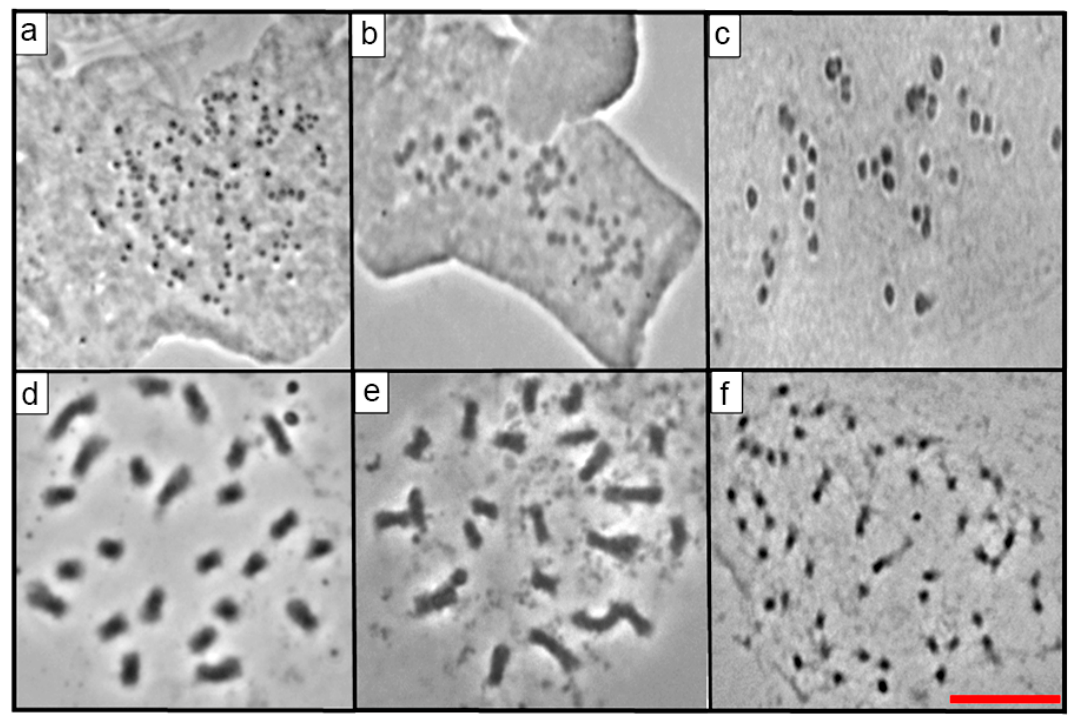
Figure 1. ( a ) Echeveria altamirae 2 n = 108, ( b ) E. caamanoi 2 n = 60, ( c ) E. carnicolor 2 n = 36, ( d ) E. catorce 2 n = 24 (Accession number JE-5469), ( e ) E. catorce 2 n = 24 (Accession number EK-3223), ( f ) E. cuicatecana 2 n = 60. Scale equals 10 µm.